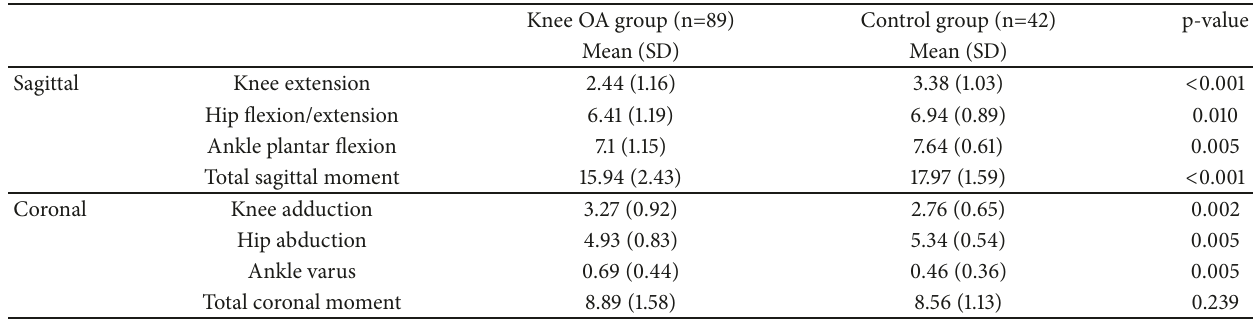
Table 3: Mean peak moment of each joint.